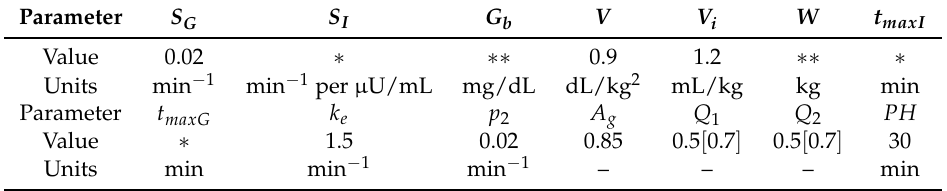
Table 1. Values of the parameters used in the forecasting algorithm. ∗ indicates parameters that are identified and ∗∗ indicates parameters that are known from a priori information from the subjects. The rest of the parameters are fixed to mean population values obtained from the scientific literature